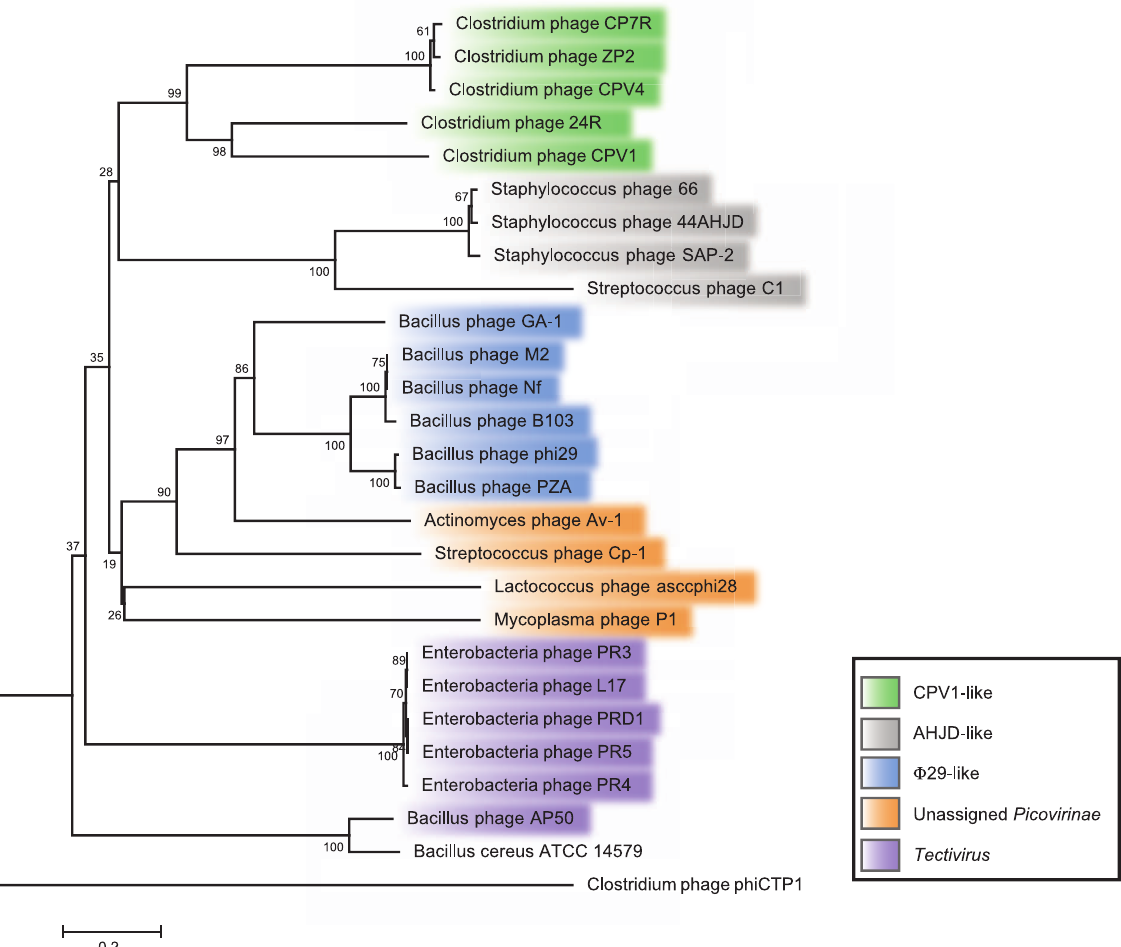
Figure 5. Phylogenetic Relationships of W CPV4, W ZP2 and W CP7R among other related Bacteriophages based on the DNA Polymerase Protein. Phylogenetic analysis of polymerase amino acid sequences were completed in MEGA5 utilizing MUSCLE for alignments with two thousand bootstrap replications and the Clostridium phage W CTP1 polymerase outgroup.